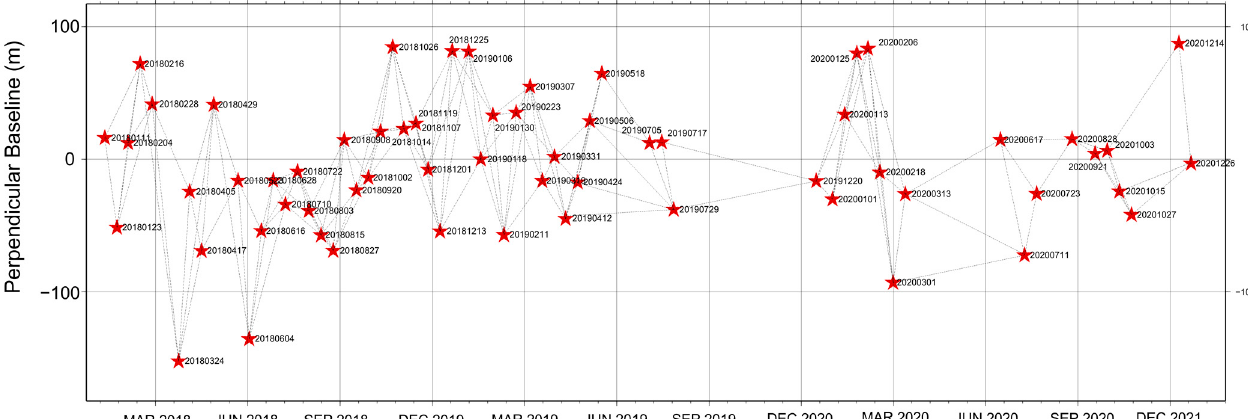
Figure 7. The cross-comparison results. 4.1.3. Identification and Analysis of the Potential Settlement Points on the Analysed Archipelago From Figure 8a, we can identify that obvious surface subsidence occurred on the west coast of Nanchangshan Island. After a detailed analysis of this area, we first enlarged the deformation field in this area to obtain the regional surface deformation distribution map, as shown in Figure 8b. The results showed that the surface deformation in this area was relatively large and occurred in an area in which construction was planned during the monitoring period, mainly due to the ground settlement caused by the ground construc- tion. One of the points was selected for time series analysis (point P in Figure 8b), and the results showed that the point presented a continuous deformation feature from 2018 to the end of 2020 (Figure 9). The land subsidence in 2018 was approximately 40 mm, in 2019 was approximately 65 mm, in 2020 was approximately 30 mm and the total subsidence in three years was approximately 135 mm, with an average annual subsidence of approxi- mately 45 mm.